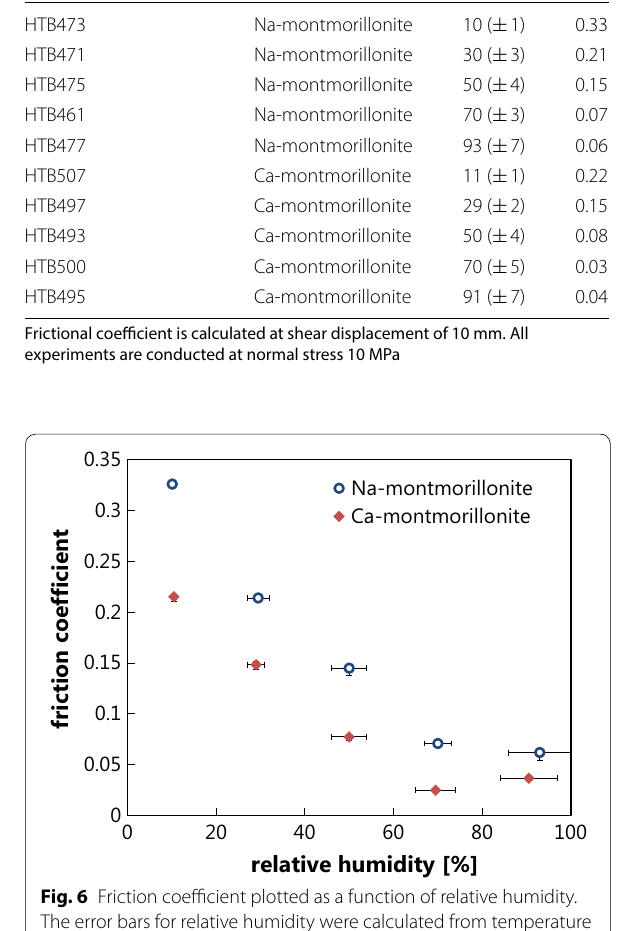
Effect of humidity and interlayer cations on the frictional Table 1 Friction coefficient ( µ ) results determined at dif-